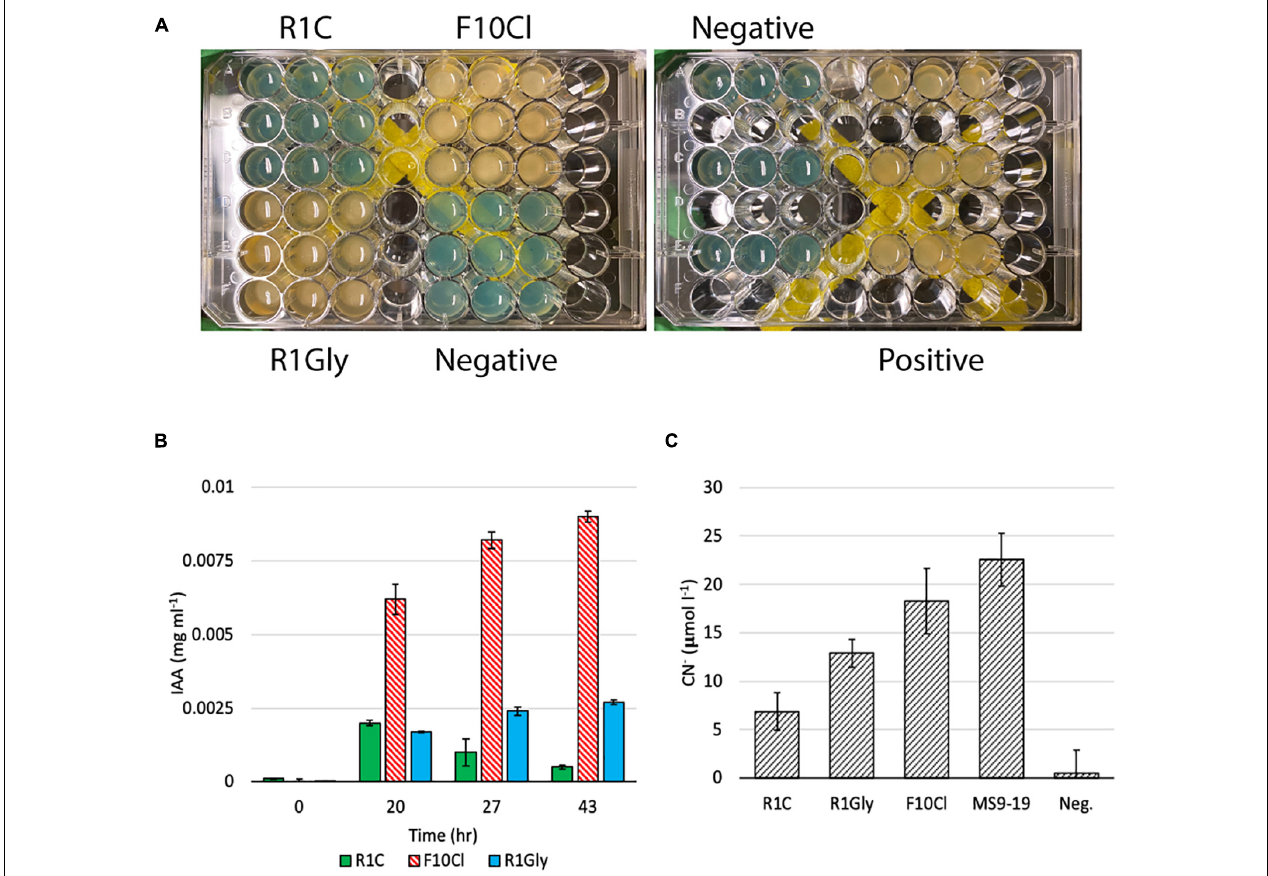
FIGURE 3 | (A) Results of the qualitative siderophore O-CAS assay. Yellow color indicates production of hydroxamate-type siderophore and blue color indicates no siderophore production detected. Pseudomonas marginalis strain MS5-19 was utilized as a positive control. (B) Indole-3-acetic acid (IAA) production by strains R1C, F10Cl, and R1Gly over 43 h with tryptophan amended. (C) HCN biosynthesis measured as aqueous concentration of CN − ( µ mol l − 1 ). Paraburkholderia fungorum strain MS9-19 was utilized as a positive control. Error bars represent one standard deviation of three biological